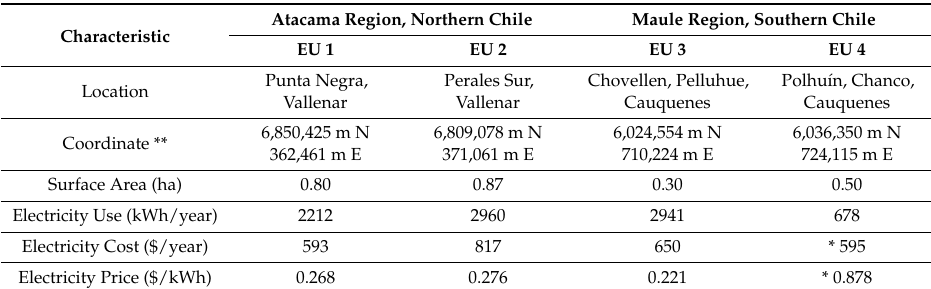
Table 1. Location of the experimental units